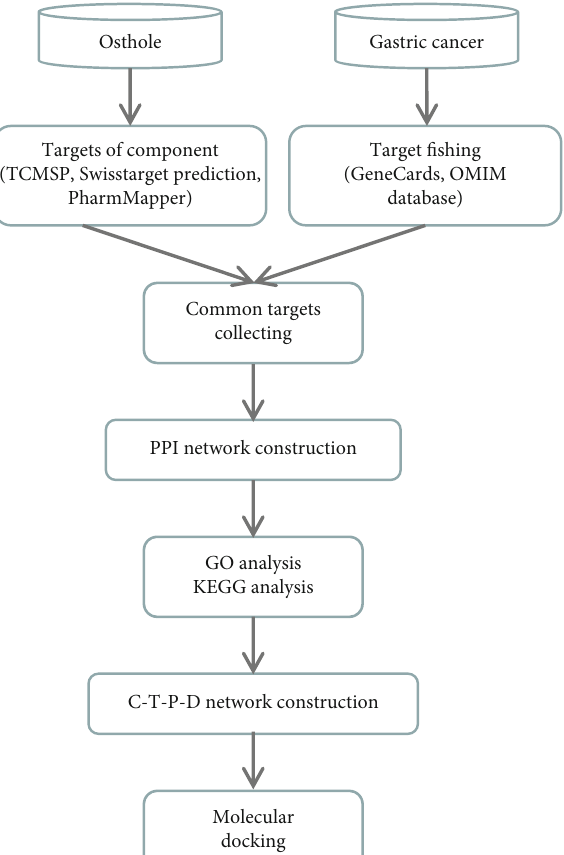
Figure 1: Network pharmacology work fl ow of